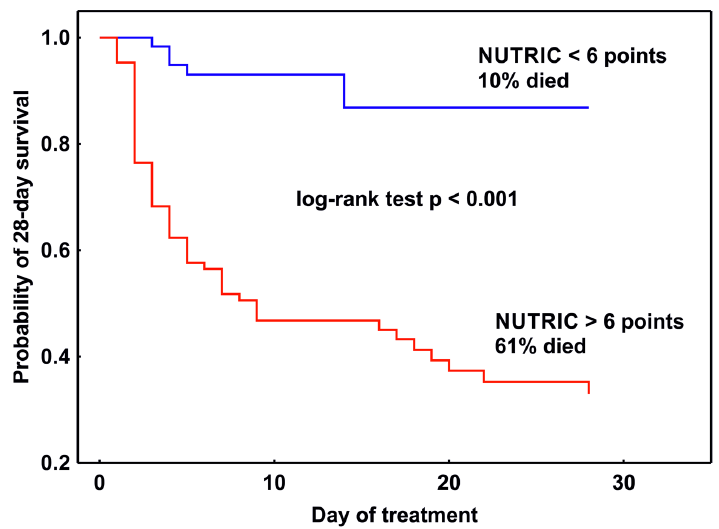
Figure 2. Comparison of 28-day survival in 2 groups of patients with sepsis on admission to the ICU based on the calculated value of the mNUTRIC score. Table 5. Univariate and multivariate logistic regression analysis of the predictors of 28-day mortality. All parameters refer to the day of ICU